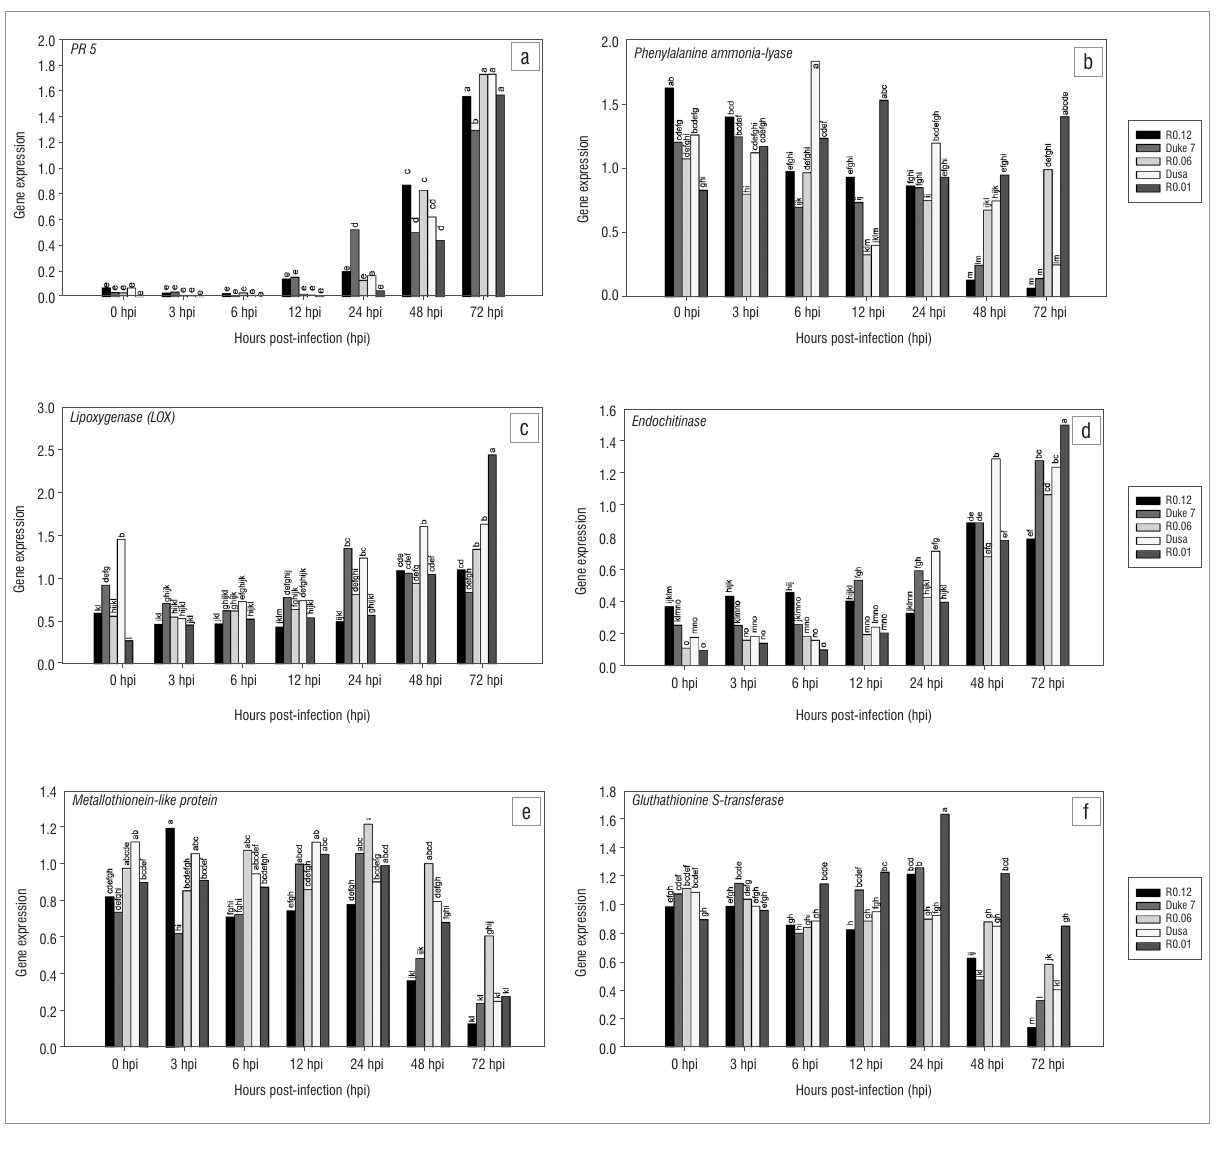
Expression ratios were determined by quantitative reverse transcription PCR. Data sets were analysed using ANOVA and a Student’s t­test using least squares means. Bars represented by the same letter are not significantly different at p<0.05. Figure 3: Relative expression levels of defence-associated genes: (a) PR 5 , (b) phenylalanine ammonia lyase , (c) lipoxygenase LOX (d) endochitinase , (e) metallothionein­like protein and (f) gluthathionine S­transferase in avocado rootstocks infected with Phytophthora cinnamomi at 0 h, 3 h, 6 h, 12 h, 24 h, 48 h and 72 h post-infection